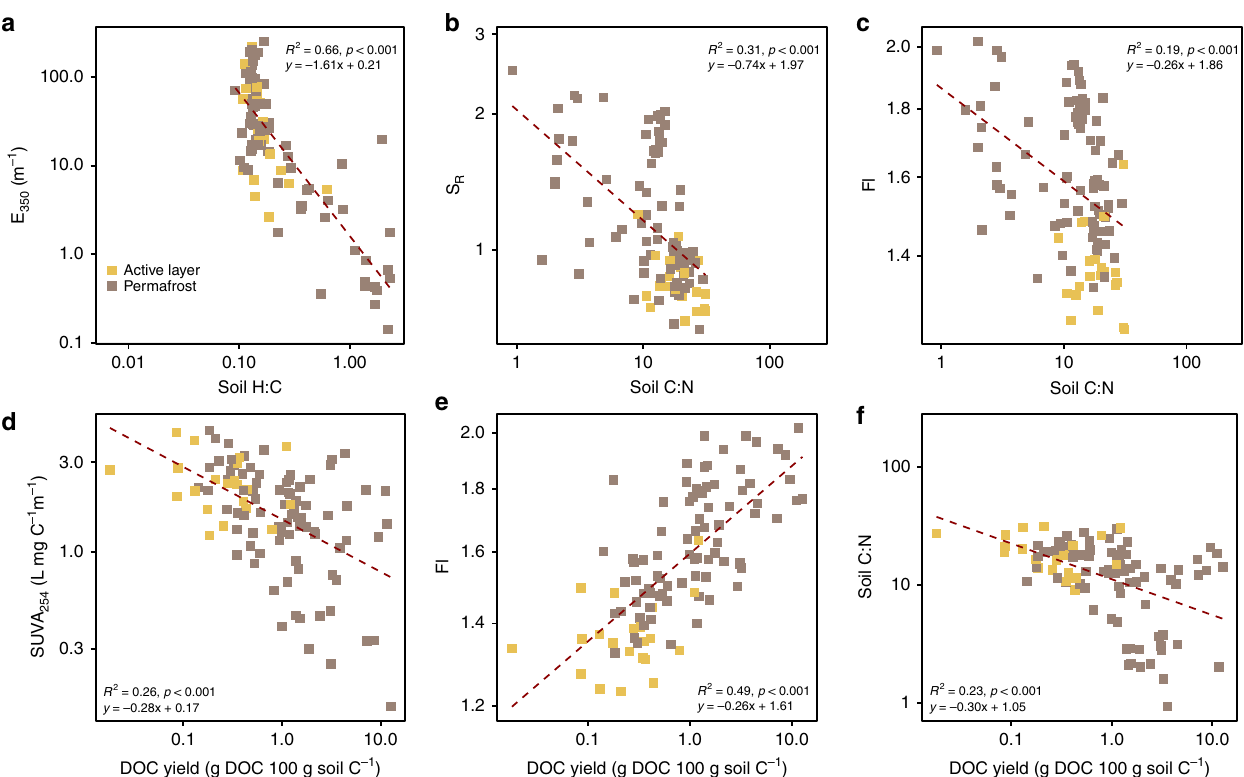
Fig. 5 Relationships between indices of DOM character and soil properties. Relationships between E 350 ( a ), S R ( b ), FI ( c , e ), SUVA 254 (L mg C − 1 m − 1 ) ( e )) and soil properties (H:C ( a ), C:N ( b , c , f ), and DOC yield (g DOC 100 g soil C − 1 ) ( d , e , f )) for both active layer and permafrost samples. Each point represents one sample. The linear regression lines and equations are for active layer and permafrost